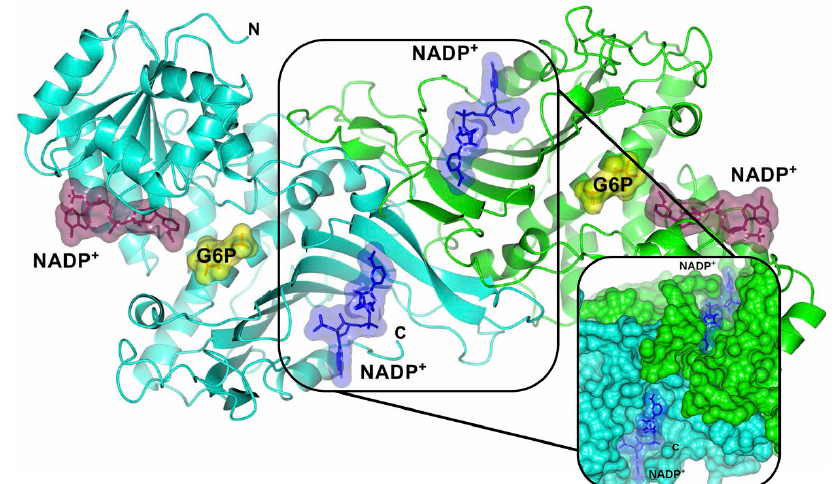
Figure 2. Crystallographic structure of the human wild-type (WT) G6PD enzyme (PDB entries 2BHL and 2BH9), showing the structural NADP + ( blue molecular surface), catalytic NADP + (dark purple molecular surface), and G6P substrate ( yellow molecular surface) in the dimer. The two monomers are shown in cyan and green . Right inset, close-up of the dimer interface and both structural NADP + molecules. The figure was prepared using Collaborative Computational Project Number 4-Molecular Graphics (CCP4mg) (Didcot, UK) [28]. The same color code for G6PD enzyme is used in all other figures.